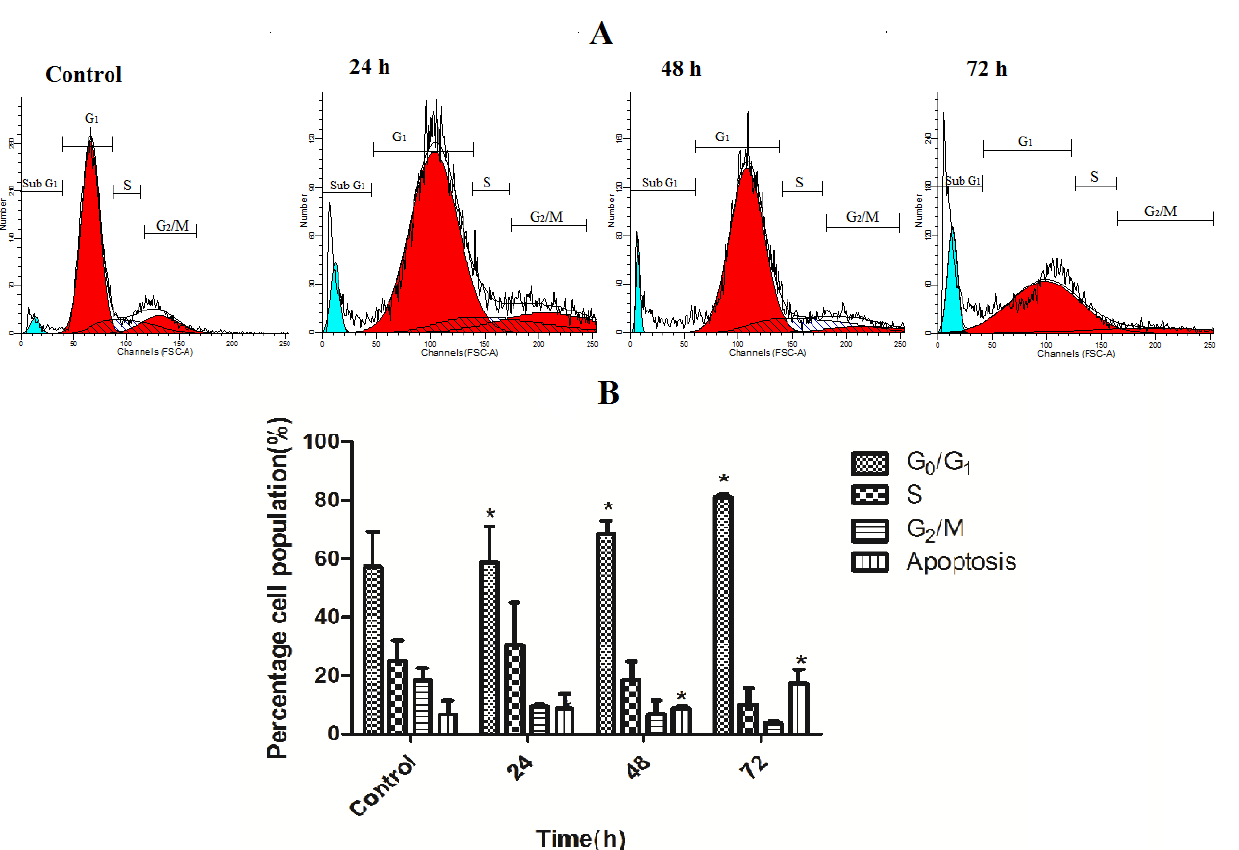
Figure 6. Effect of TPHE studied on cell cycle distribution of MCF7 cells. ( A ) After treatment with IC concentration of TPHE for 24, 48 and 72 h, flow cytometry was used 50 to analyze the cell cycle. ( B ) The result demonstrated the cell cycle arrest at G phase. The 1 percentage of apoptotic cells indicated the subG population after 24, 48 and 72 h treatment. 1 The data are shown as the mean ± SD ( n = 3). * represents significant difference ( p < 0.05) compared with the control.